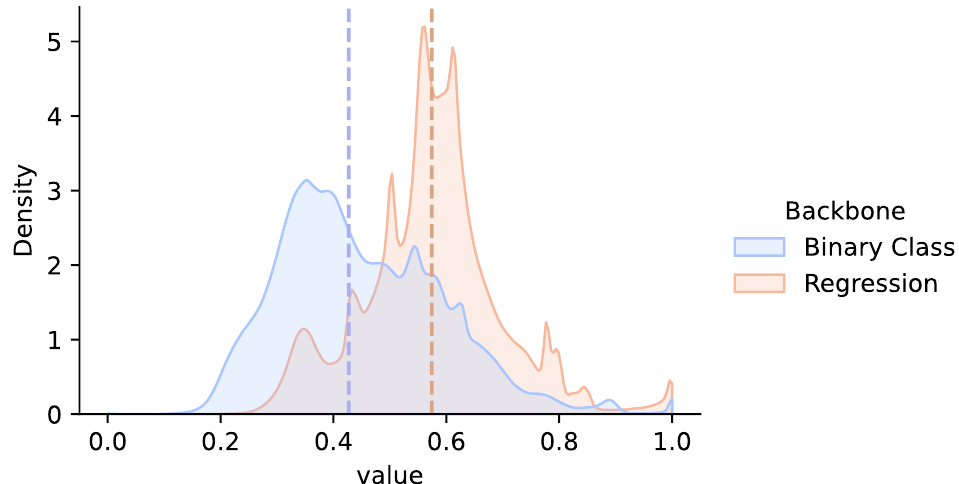
Figure 6. Values distributions for each attention level of the regression backbone. The dashed lines represents the medians of the two distributions.